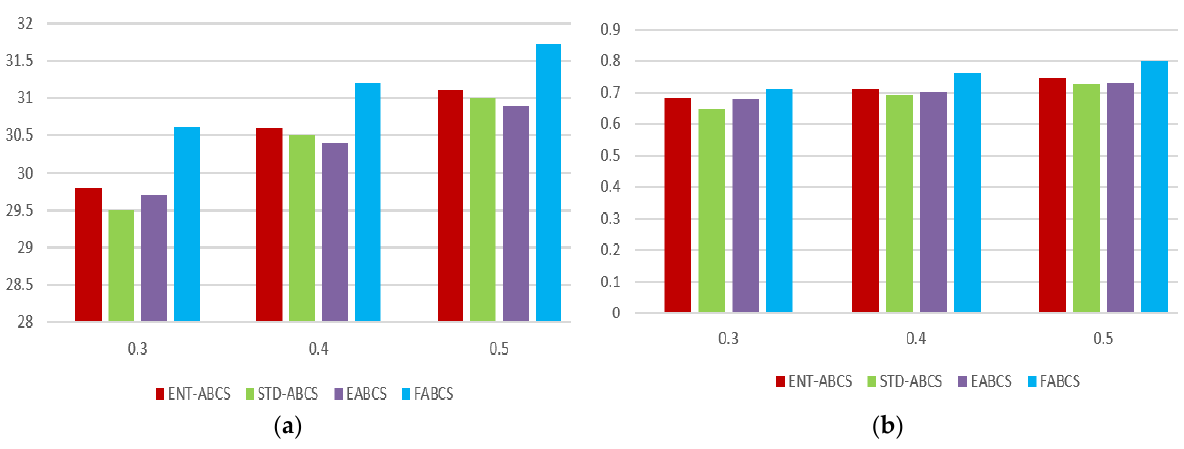
Figure 8. Performance comparison of different algorithms on Set5 Test images based on ( a ) Average PSNR and ( b ) Average SSIM.